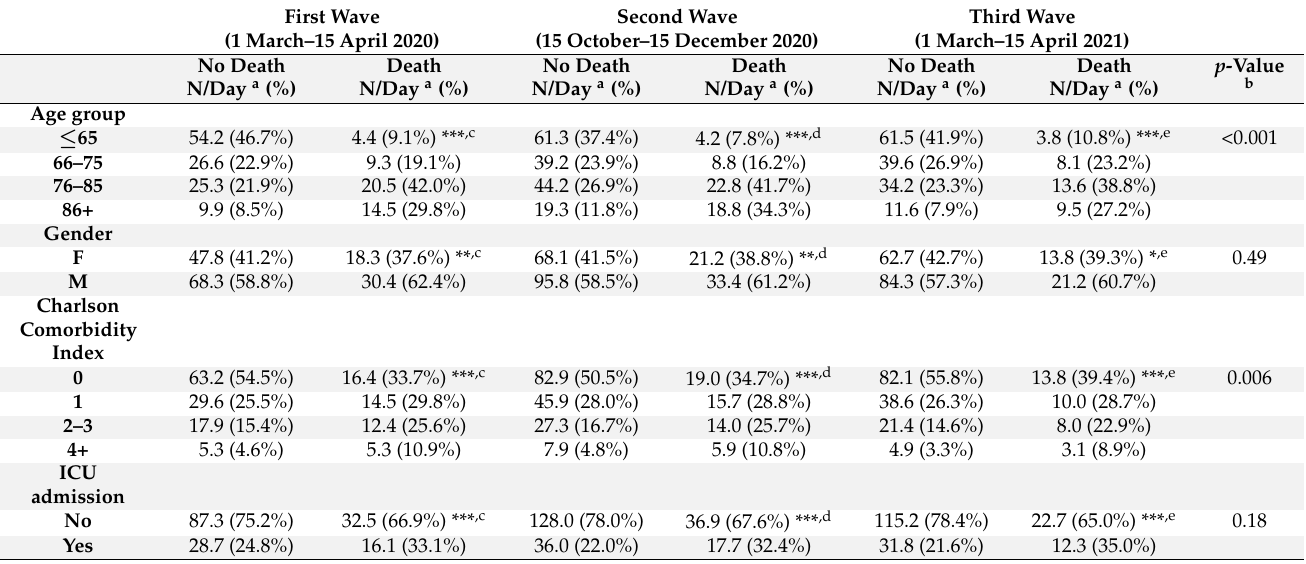
Table 5. Demographic characteristics, comorbid conditions, and intensive care unit (ICU) admission of hospitalized for SARS-CoV-2, stratifying by death within 30 days from the first positive swab and